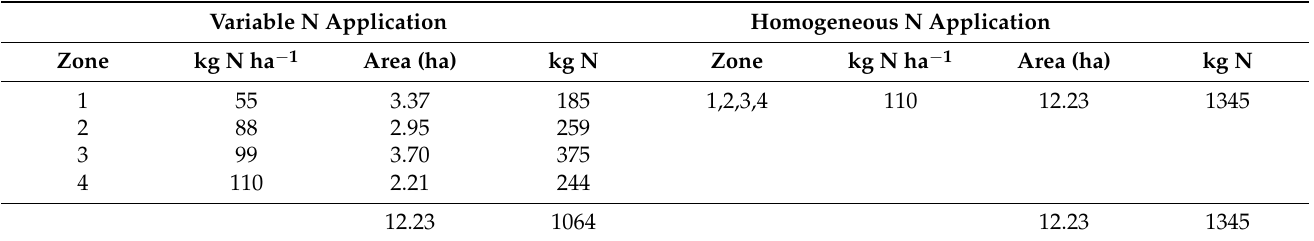
Table 3. Dose of N applied in the plot with and without